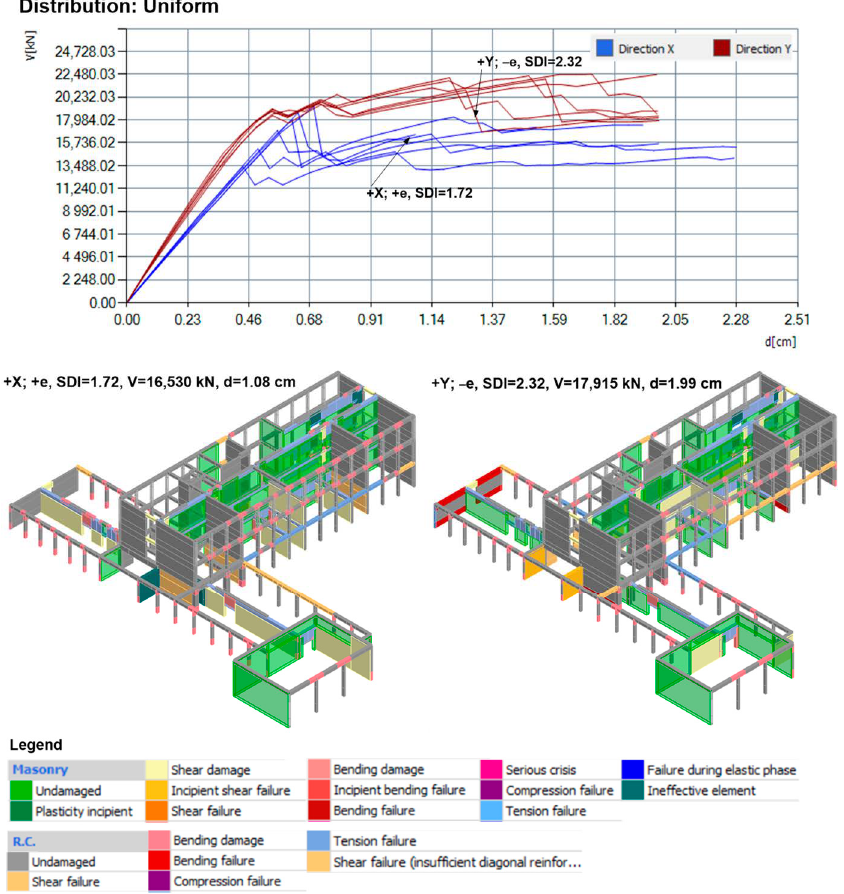
Figure 29. EFM results: pushover curves and corresponding damage mechanism of the retrofitted structure obtained using the uniform load pa tt ern.